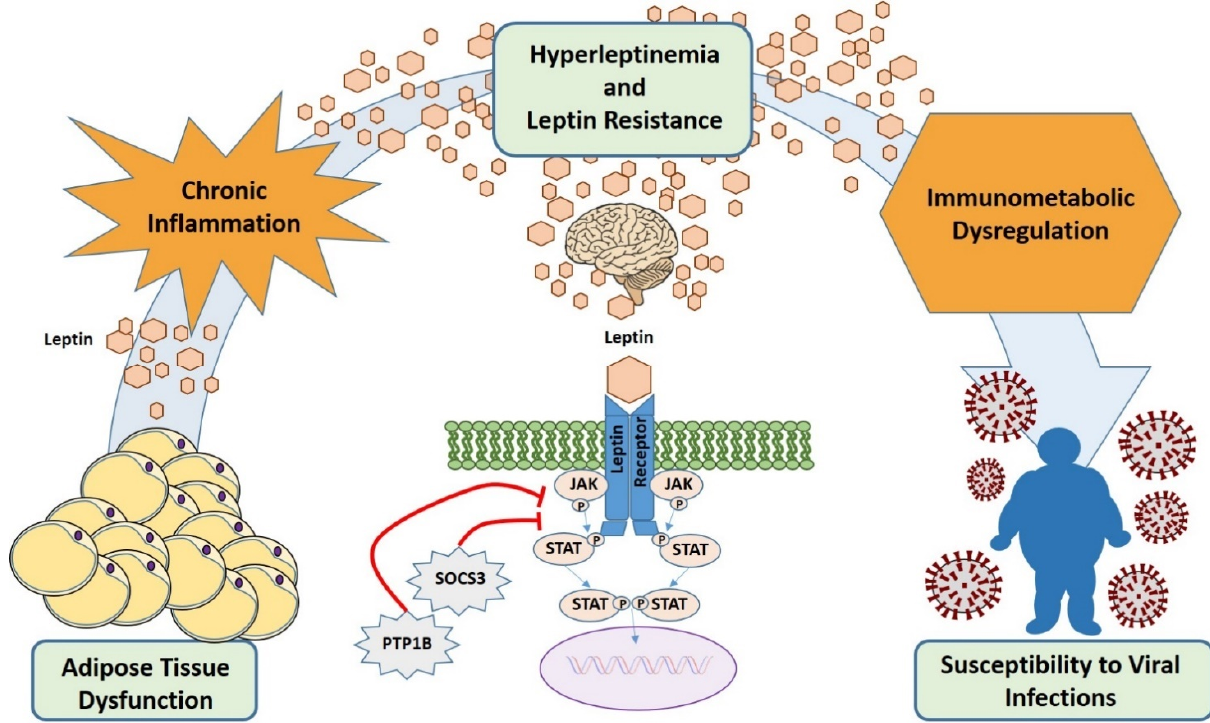
Figure 3. Hyperleptinemia and leptin resistance contribute to immune dysregulation and increased susceptibility to viral infections in obesity. In obesity, adipose tissue produces high levels of leptin (hyperleptinemia) that causes desensitization of target cells for leptin signaling (leptin resistance) by several mechanisms including overexpression of SOCS3. This results in diminished immune cells response and, finally, in an increased susceptibility to infections. In addition, the hyperleptinemia contributes to the obesity low-grade inflammatory background.